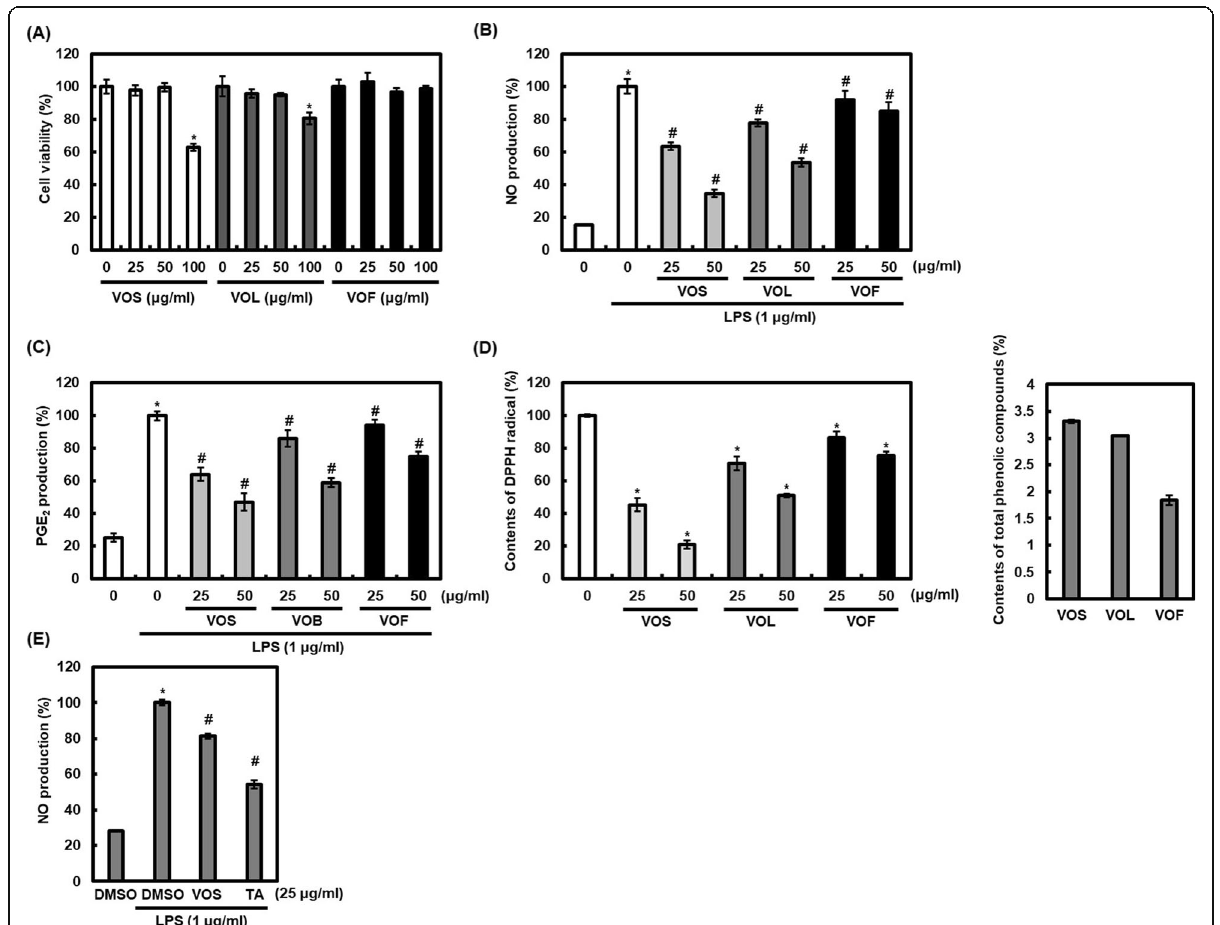
Fig. 3 Inhibitory effect of the extracts from stems (VOS), leaves (VOL) and fruits (VOF) of V. oldhami against NO and PGE 2 production in LPS- stimulated RAW264.7 cells. a RAW264.7 cells were treated with VOS, VOL or VOF for 24 h. Cell viability was measured using MTT assay. * P < 0.05 compared to the cells without the treatment. b , c RAW264.7 cells were pretreated with VOS, VOL or VOF for 6 h and then co-treated with LPS (1 μ g/ml) for 18 h. NO and PGE 2 production was measured by Griess assay and Prostaglandin E2 ELISA Kit, respectively. * P < 0.05 compared to the cells without the treatment, and # P < 0.05 compared to the cells treated with LPS alone. d Antioxidant activity and contents of total phenolic compounds of VOS, VOL and VOF were analyzed as described in Materials and methods. e RAW264.7 cells were pretreated with VOS and TA for 6 h and then co-treated with LPS (1 μ g/ml) for 18 h. NO production was measured by Griess assay. * P < 0.05 compared to the cells without the treatment, and # P < 0.05 compared to the cells treated with LPS